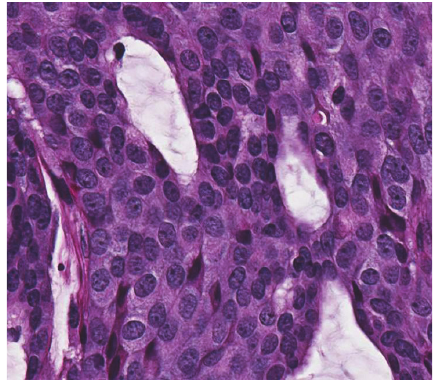
Figure 2: High power H&E slide. The nuclei are round to oval with conspicuous nucleoli and a finely stippled chromatin pattern.